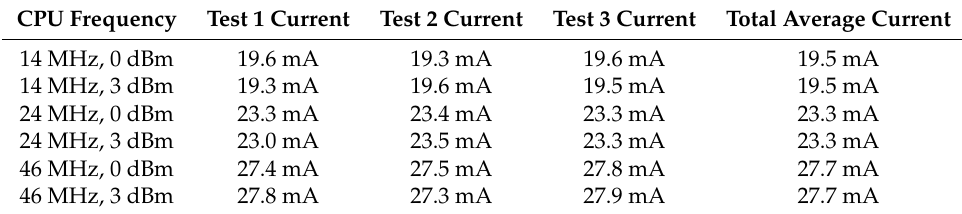
Table 3. BLE device current drawn for transceiver and deep sleep.